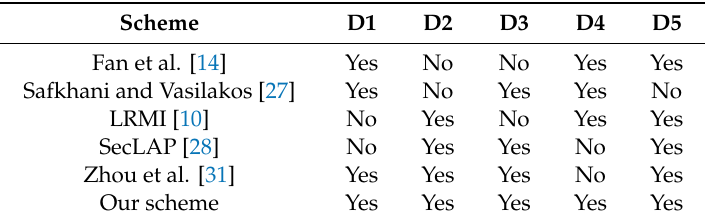
Table 3. Security performance